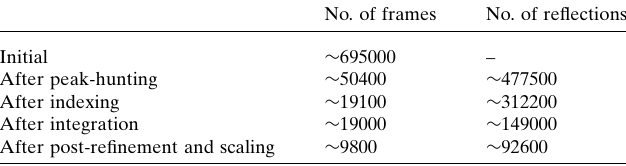
Table 2 Pipeline statistics for the data reduction of the PtPOP data measured at SACLA.